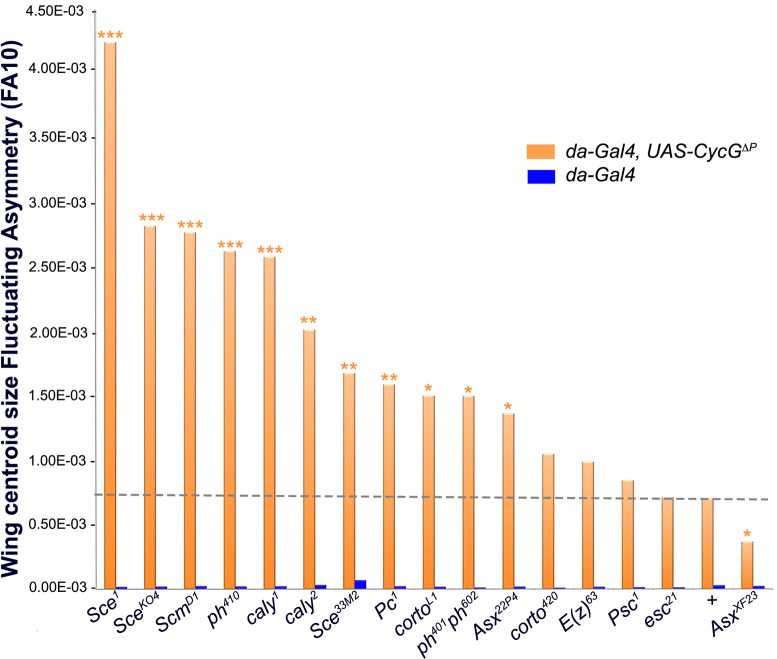
CycG interacts with several PcG and
ETP genes for developmental stability.Centroid size FA (FA10) of ETP or PcG
heterozygous mutant females combined with da-Gal4,
UAS-CycGΔP (dark
orange; da-Gal4,
UAS-CycGΔP;
PcG/+ or da-Gal4,
UAS-CycGΔP;
ETP/+) and ETP or
PcG heterozygous mutant females combined with
da-Gal4 (blue; da-Gal4/+; PcG/+ or
da-Gal4; ETP/+). The grey dashed
line shows FA of da-Gal4,
UAS-CycGΔP/+
females. (F-tests, *p-value<0.05; ** p-value<0.01; ***
p-value<0.001, S5 Table). Source data are provided
in S6
Table.